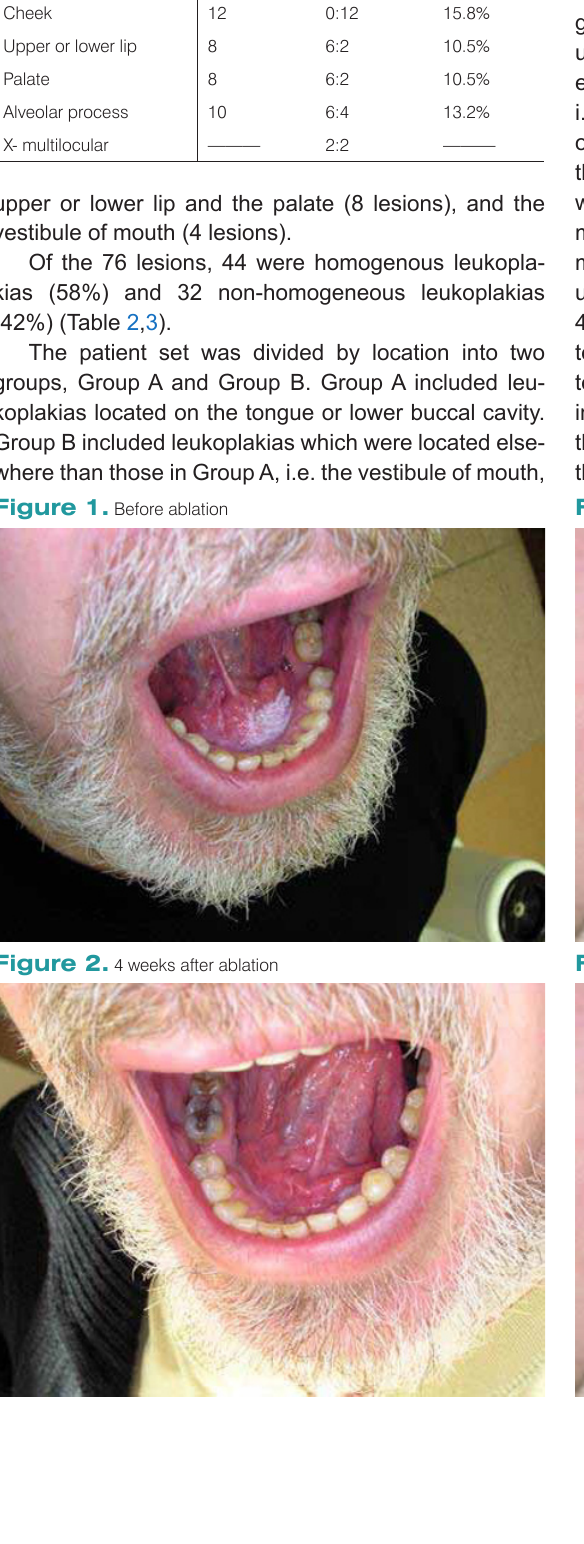
Table 1. Localisation of lesions; (M: male; F: female)